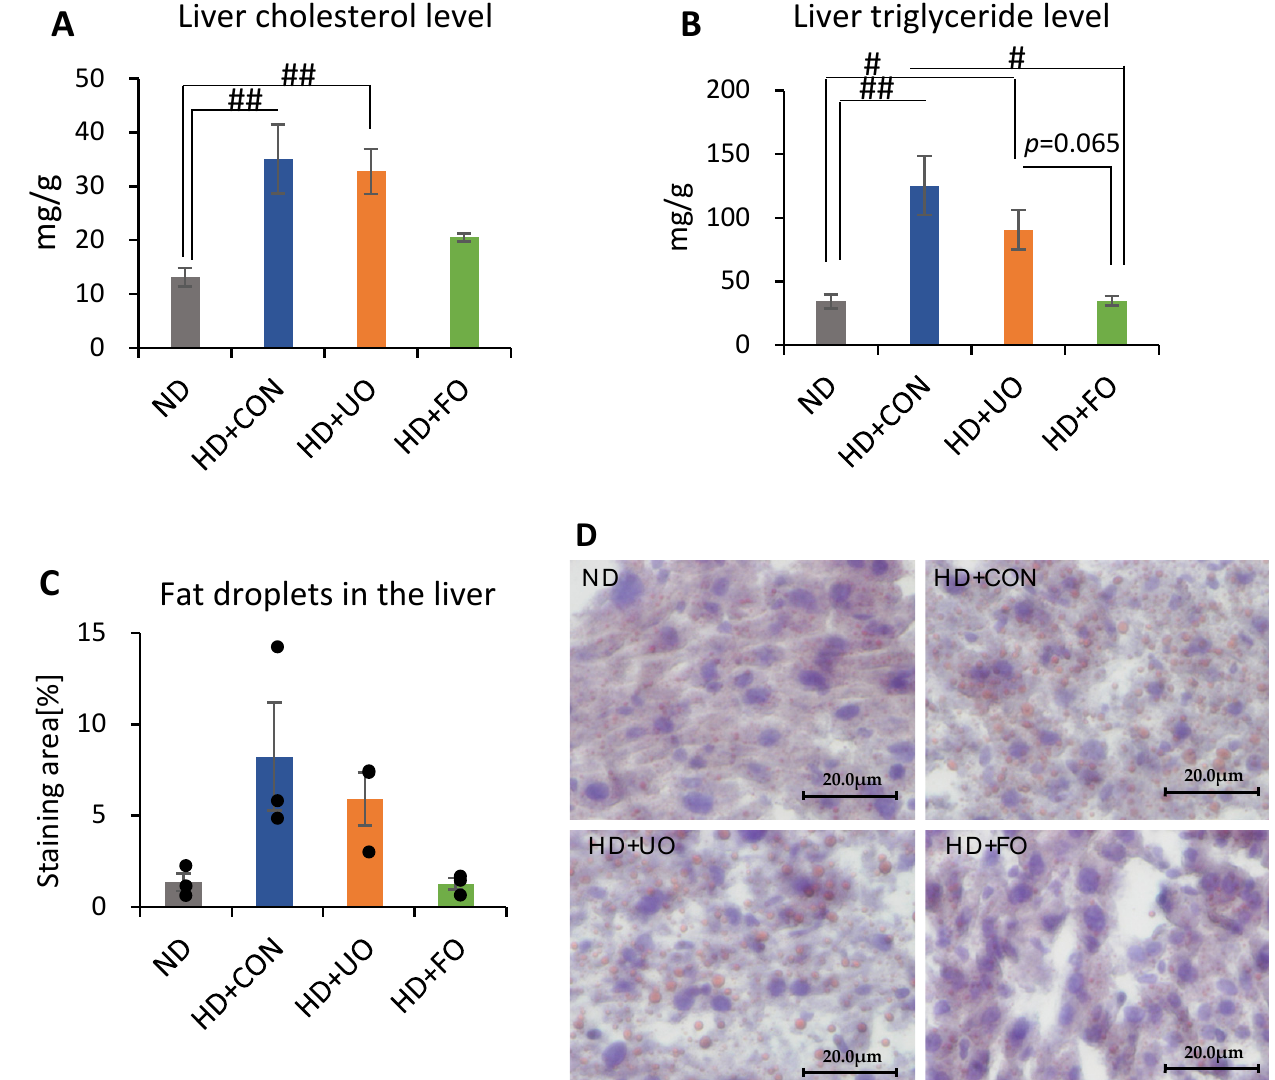
Figure 5. The lipid profile in the liver (cholesterol and triglyceride). Cholesterol lipid ( A ), triglyceride lipid ( B ) levels, lipid droplet size represented by the stained area ( n = 3; each sample value is shown in black dots) ( C ), Oil Red O staining ( D ) of liver section of mice fed each experimental diet for 3 weeks. Data are represented as mean ± SEM (ND, HD + CON, HD + UO: n = 6, HD + FO: n = 7) # p < 0.05, ## p < 0.01 evaluated using the Kruskal − Wallis test with Dunn’s post-hoc test.